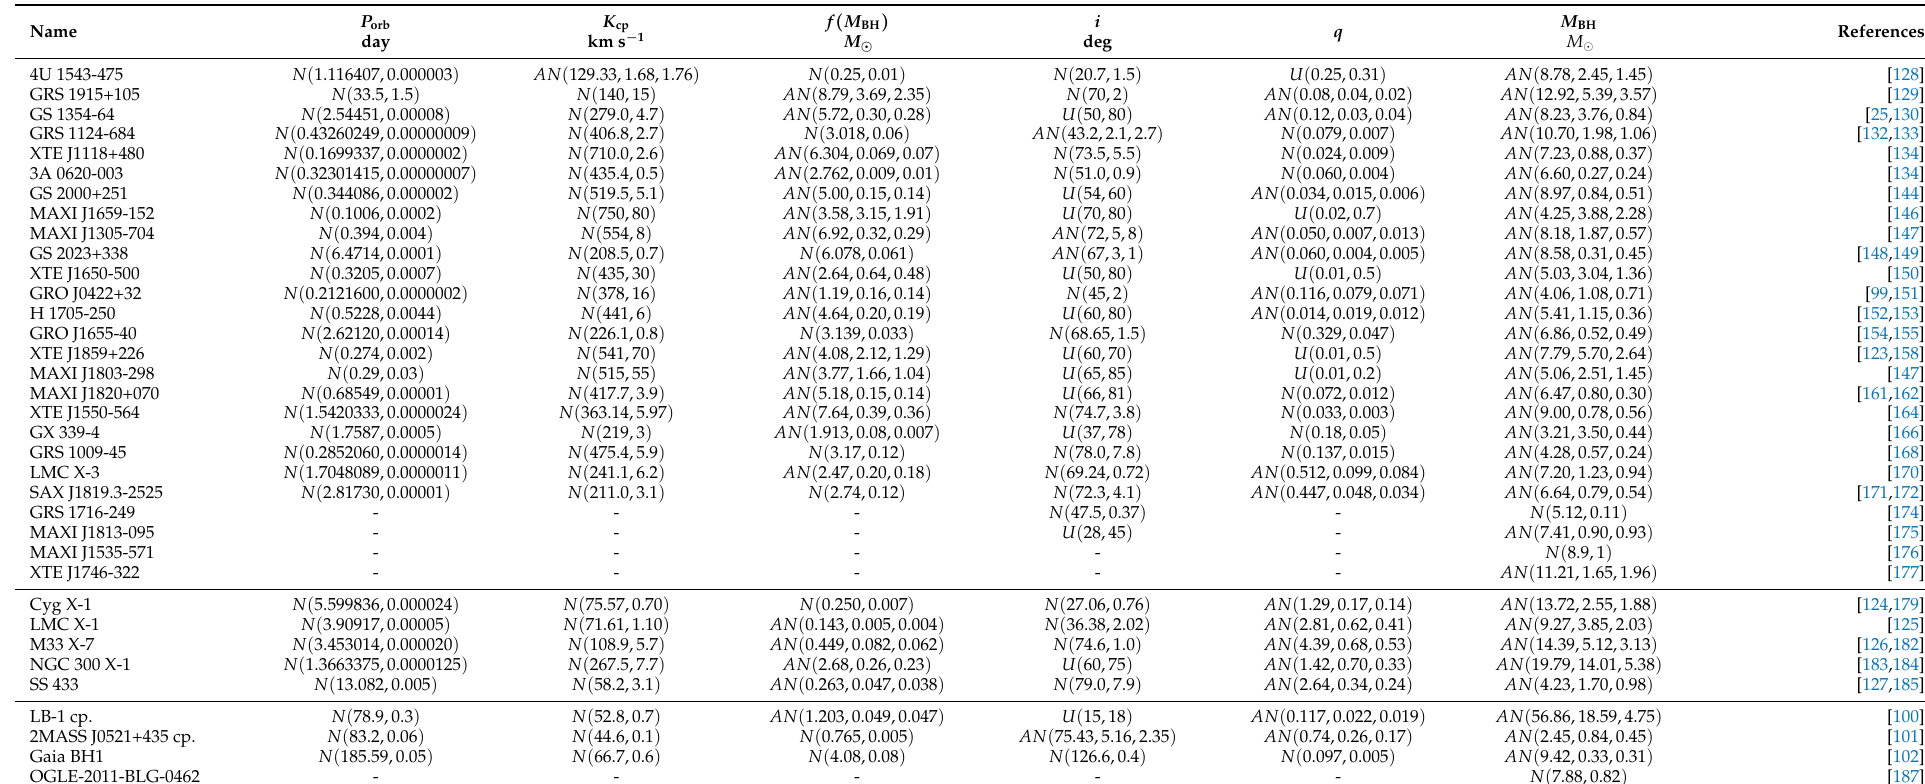
Table 3. Masses and Binary Parameters, where applicable, for 35 Black Hole